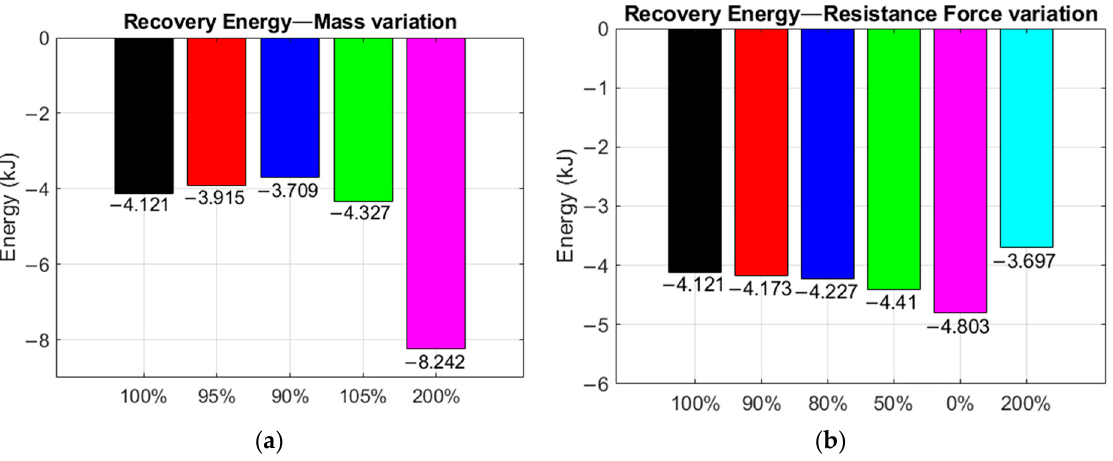
( b ) Figure 10. Energy recovery in the case for varied resistance force optimization attempts: ( a ) energy– time display; ( b ) energy–distance display.